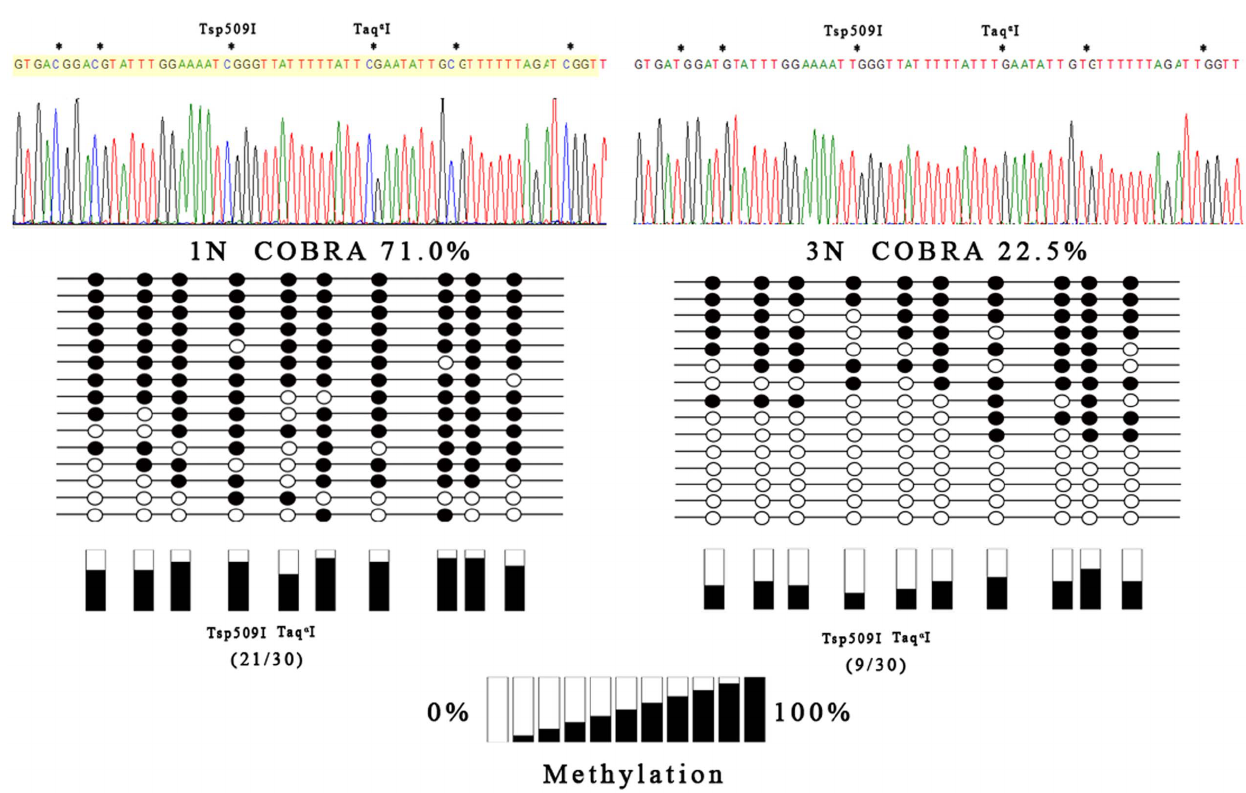
Figure 3. Results of LINE-1 bisulfite sequencing. Bisulfite converted DNA sequences and a typical sequencing result is shown at the top panel. Asterisks indicate the CpG sites. The cutting sites for Tsp509I and Taq a I were marked. 15 clones representing five first trimester (1N, left penal) placentas (3 clones each) and 15 clones representing five third trimester (3N, right panel) placentas (3 clones each) were sequenced. The solid and open circles represent the methylated CpG dinucleotides and unmethylated CpG, respectively. Methylation levels of each CpG sites were illustrated at the bottom panel. The CpG sites of LINE-1 in 3N placentas are generally hypomethylated relative to 1N placentas.